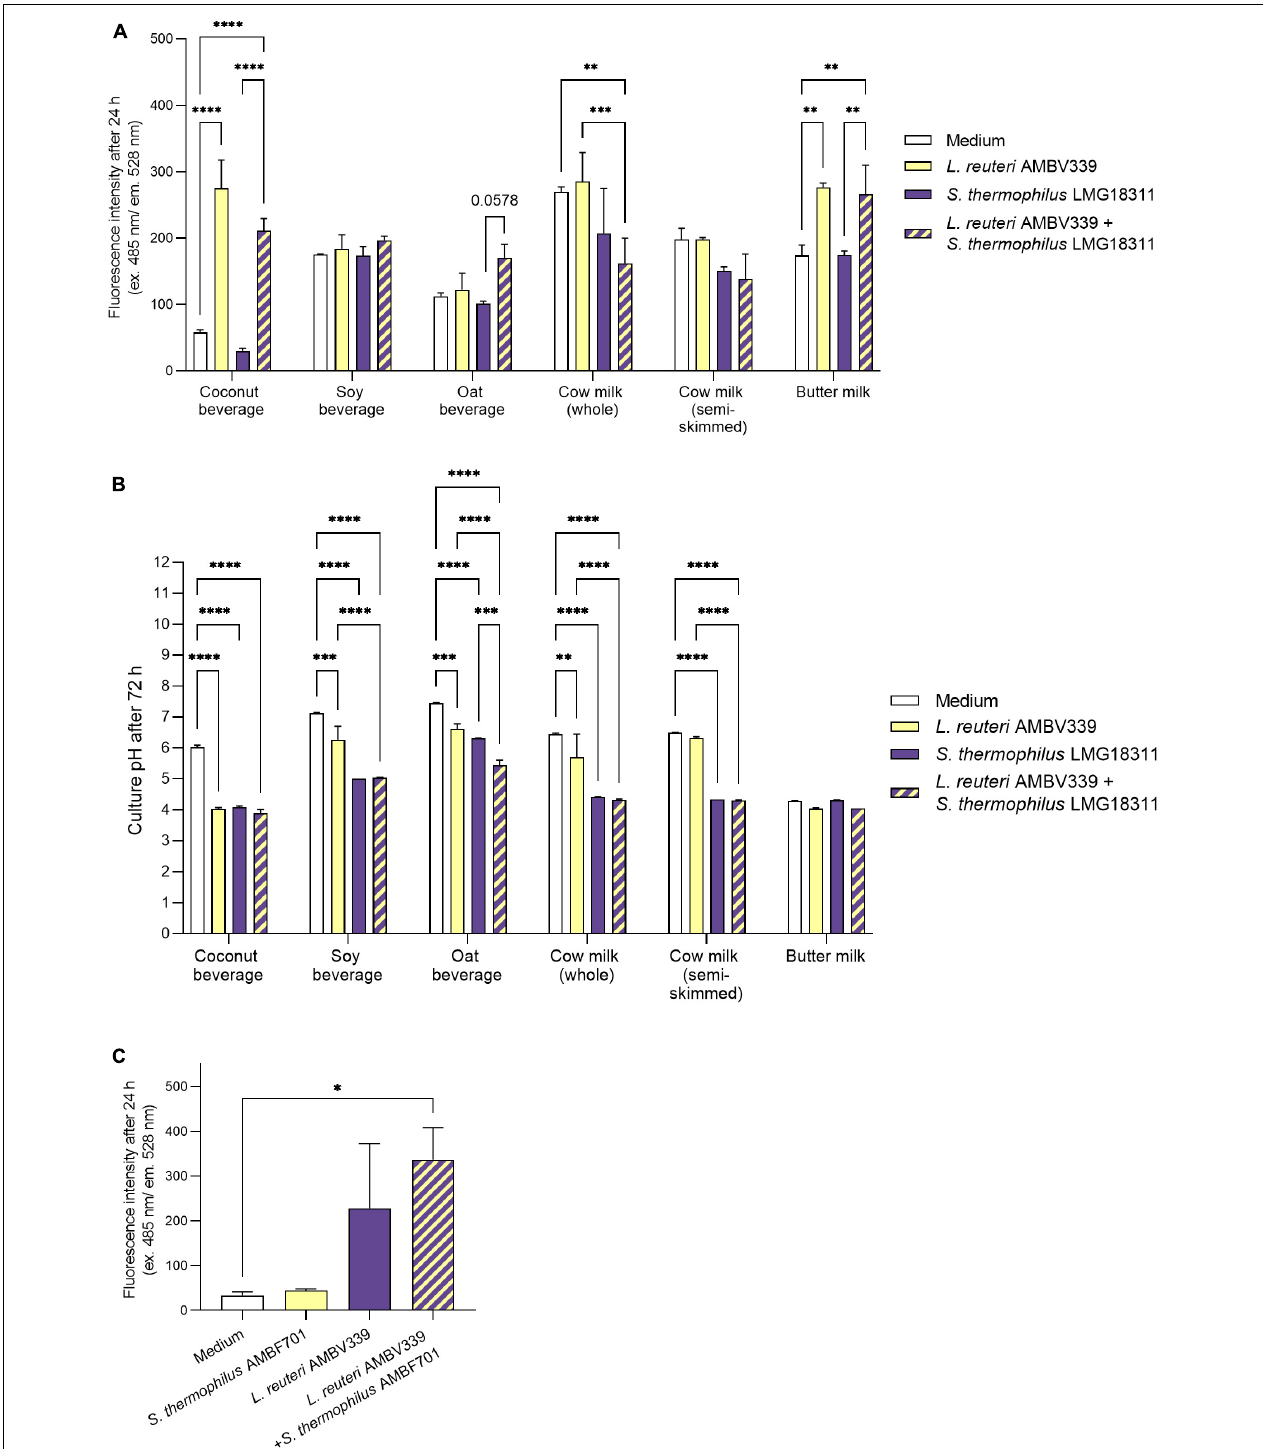
FIGURE 2 | (A) Riboflavin production in 24 h cultures of L. reuteri AMBV339 and S. thermophilus LMG18311 alone or combined in coconut, soy and oat beverages, whole and semi-skimmed cow milk, and butter milk, and (B) final culture pH after 72 h. (C) Riboflavin production in 24 h cultures of L. reuteri AMBV339 and S. thermophilus AMBF701 alone or co-cultured in a coconut beverage. Data is presented as means ± SD. ∗ p < 0.05, ∗∗ p < 0.01, ∗∗∗ p < 0.001, ∗∗∗∗ p < 0.0001 or depicted p -value, as determined by two-way ANOVA with Tukey’s multiple comparisons test. Comparisons were made with the medium (food matrix as such) condition, or with the L. reuteri AMBV339 + S. thermophilus conditions.